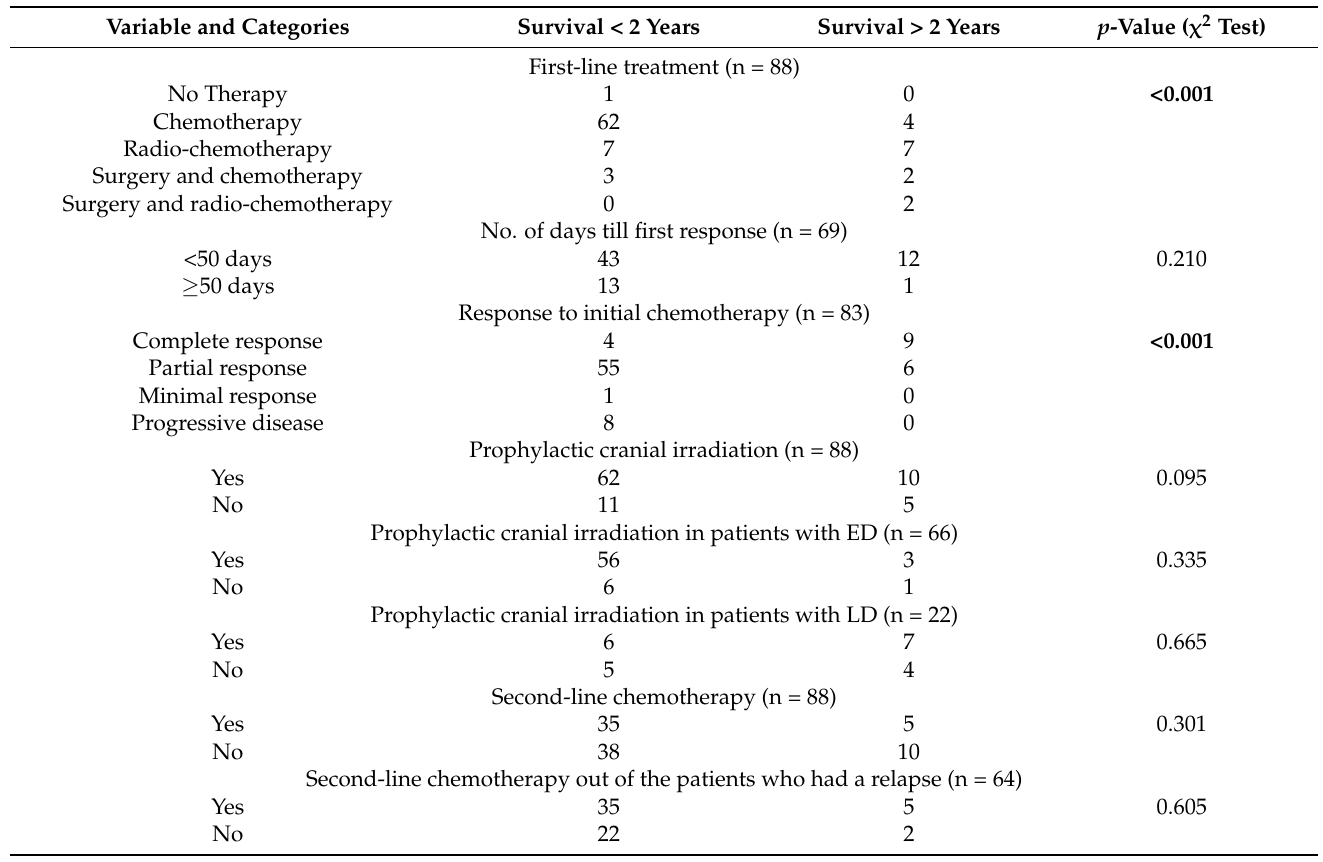
Table 7. Therapy parameters and their correlation to long-term survival.